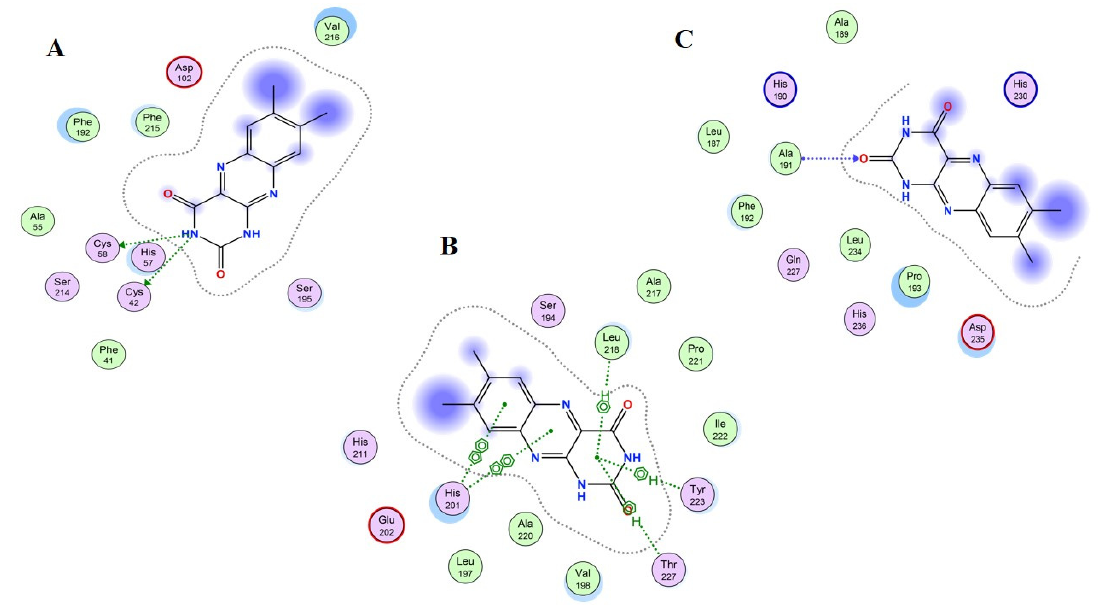
Figure 10. Schematic representation of Compound 11 “lumichrome” bonded in the active site of selected three proteins (PDB ID: 1H1B ( A ), 1QIB ( B ) and 4H1Q ( C )). The active binding site shows hydrogen-bonding capacity as donor atoms (purple), and acceptor atoms (green), a two-dimensional plot showing hydrogen bonding interactions and other important hydrophobic interacting residues of the target proteins.